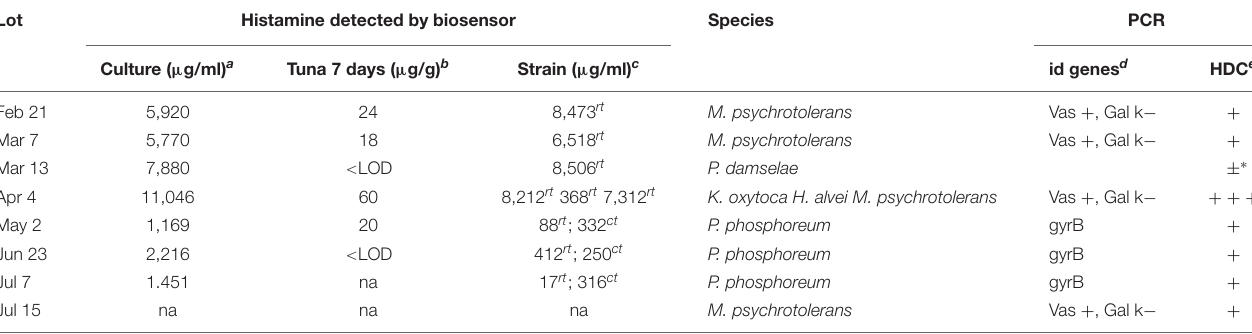
TABLE 1 | Histamine-producing bacteria isolated from fresh tuna filets and histamine level after 7 days of storage on ice. Lot Histamine detected by biosensor